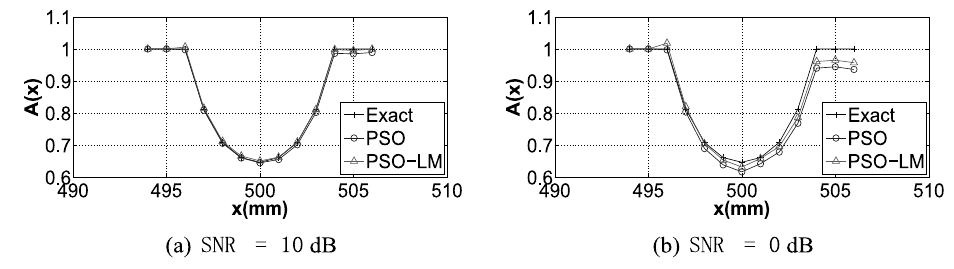
Fig. 15. Damage identi fi cation with two levels of SNR, Case